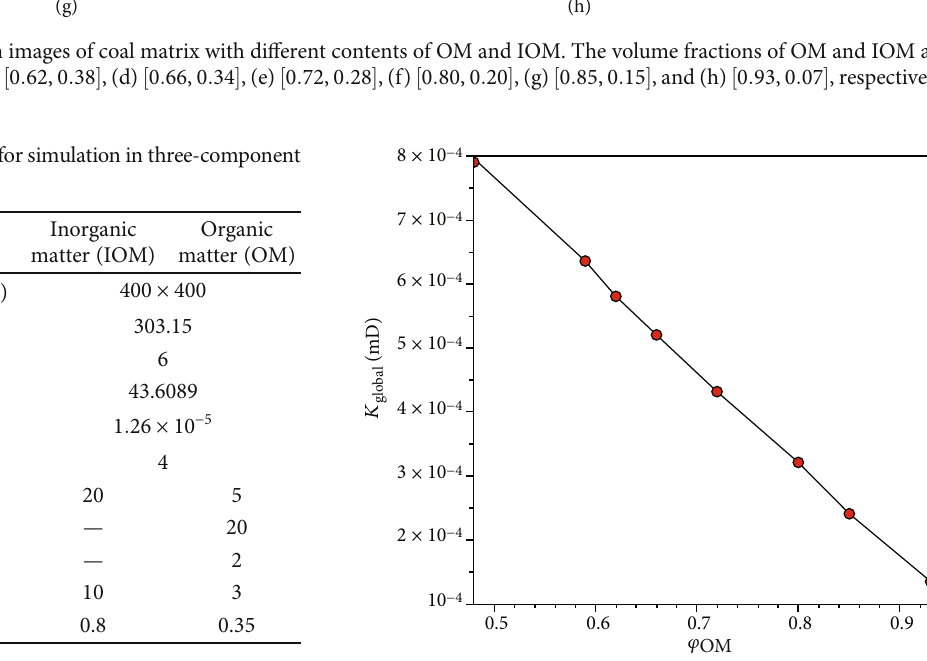
Figure 4: Changes of global permeability with OM